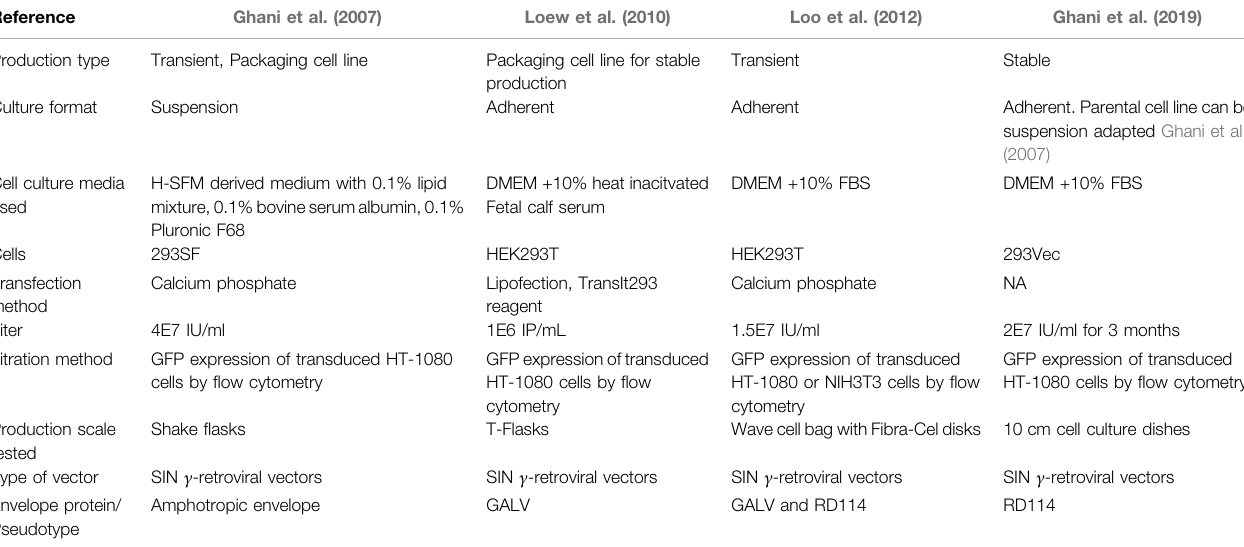
TABLE 2 | Comparison of various γ RV production methods.